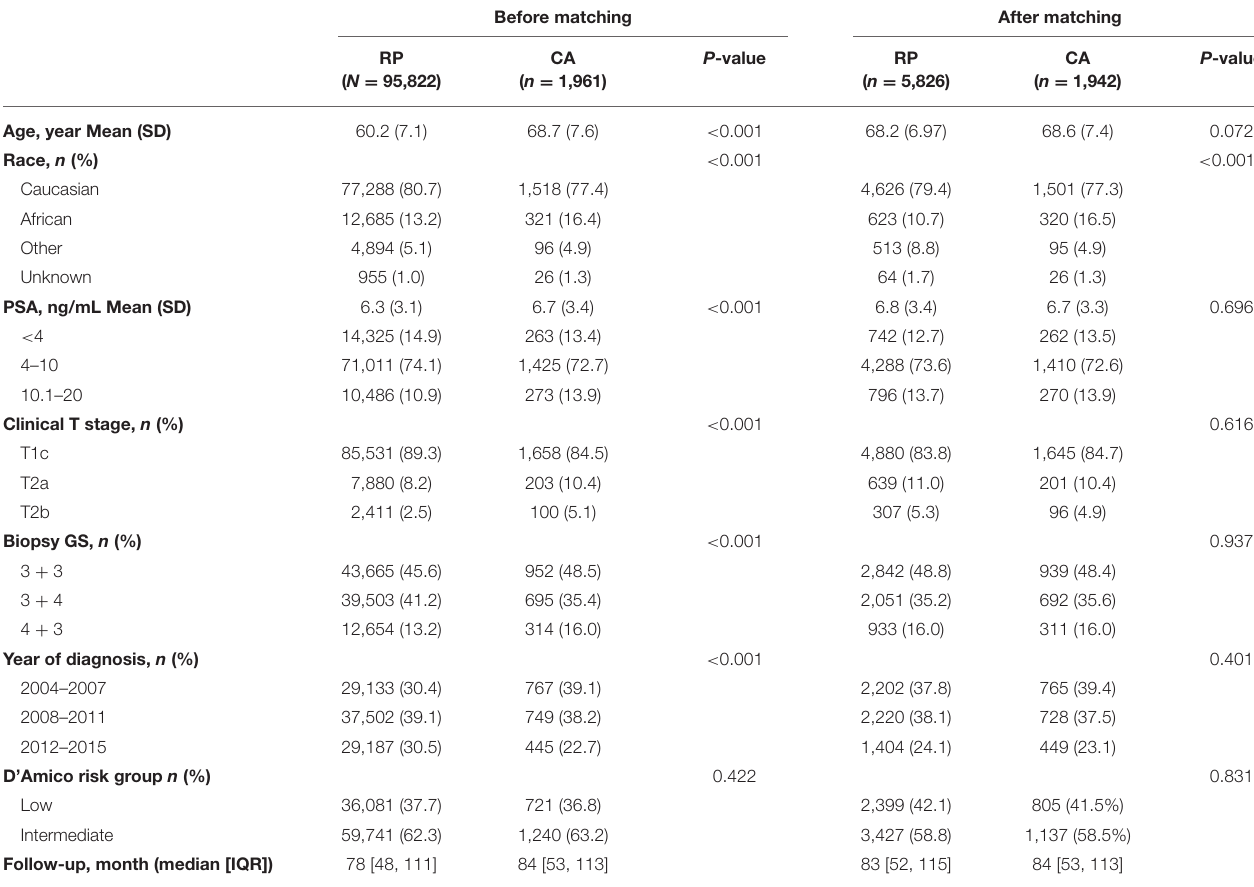
TABLE 1 | Baseline demographic and clinicopathologic characteristics sort by interventions before and after propensity score matching. Before